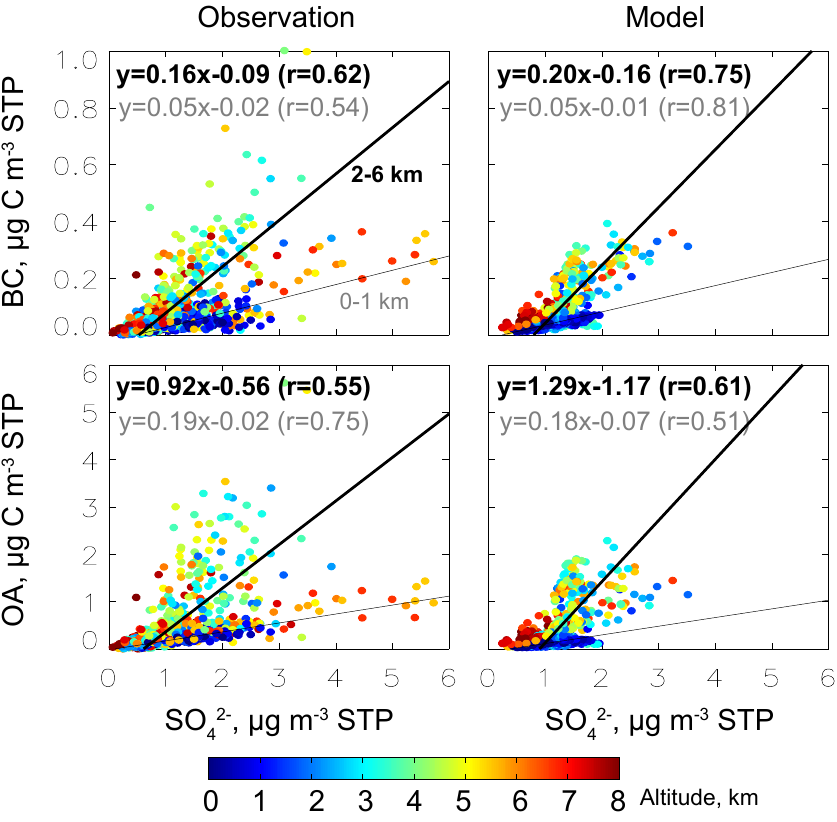
) concentrations in ARCTAS. Observations from the DC-8 aircraft (left panels) are Fig. 8. Scatterplots of BC and OA vs. sulfate (SO 2 − 4 compared to model values (right panels) sampled along the aircraft flight tracks as described in the text. Individual points are colored by altitude. Reduced-major-axis (RMA) regression statistics and linear fits are shown in thin black for near-surface data ( < 1km) and in thick black for mid-tropospheric data (2–6km).